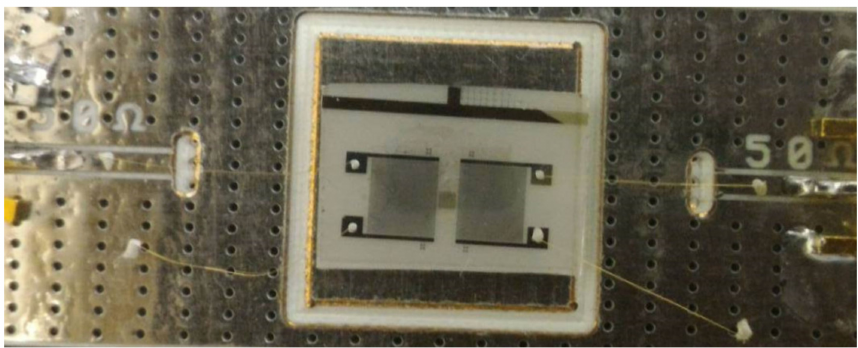
Figure 2. Fabricated SAW device connected to printed circuit board